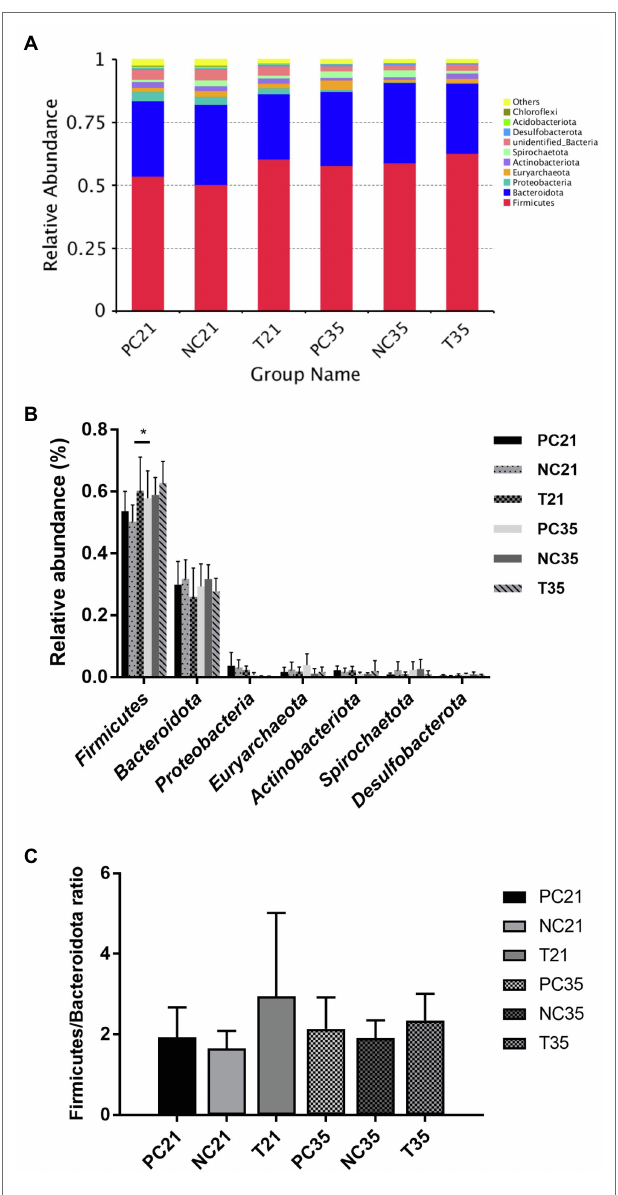
FIGURE 5 | Effects of Z. Tk and ZnO on the intestinal microbiota structure at the phylum level in weaned piglets characterized by the taxonomic distributions of the microbial communities in feces at phylum level (A) , the top five relatively abundant bacterial phyla detected in fecal samples (B) , and the Firmicutes/Bacteroidetes ratio (F/B; C ). Symbol “*” indicates the significant difference set at the values of p of 0.05. Each of the nine samples is selected from each of the three groups of piglets, i.e., the positive control (PC), the negative control (NC), and the test groups, on days 21 and 35,